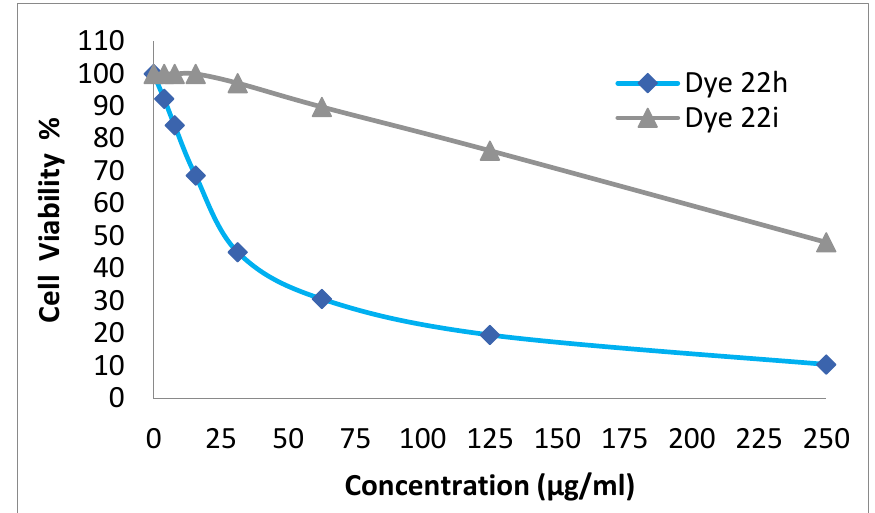
Figure 8. Antitumor (HCT-116) activities of disperse dyes 22h and 22i.